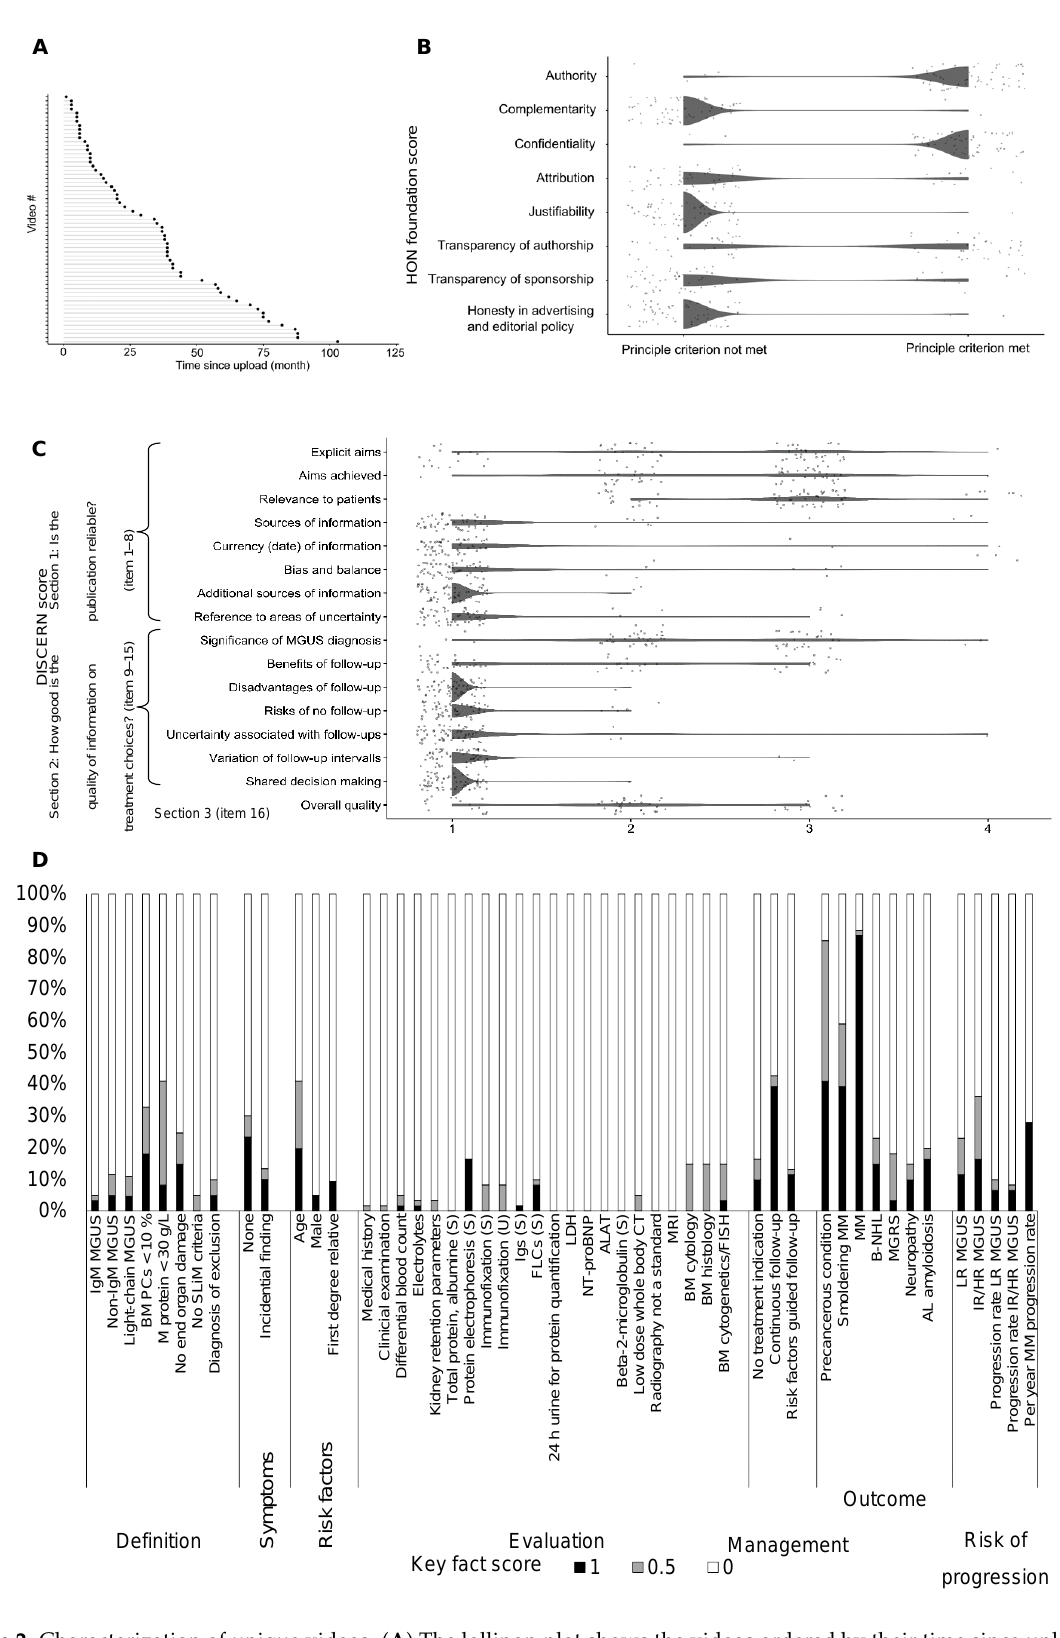
Figure 2. Characterization of unique videos. ( A ) The lollipop plot shows the videos ordered by their time since upload until the date of assessment in months. ( B ) Scatter dot plot shows the score result reached by every single video ( n = 61) for